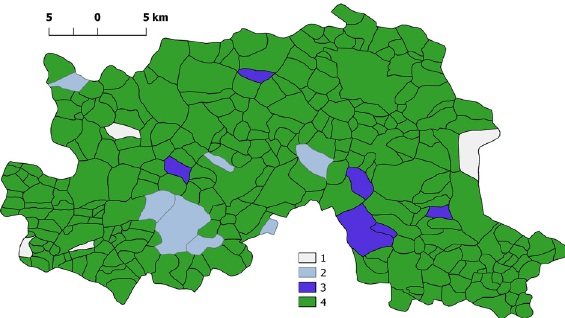
Fig. 4. Analysis of depth of underground water table analysis in Gurugram district (>20